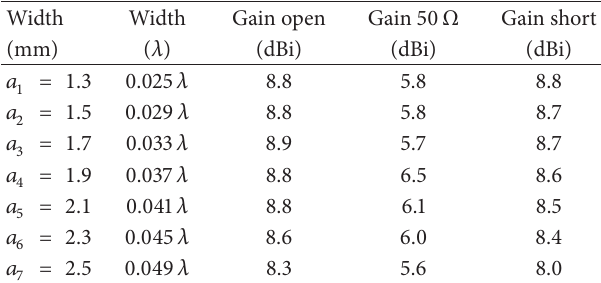
Table 1: Line width analysis (RF60A).